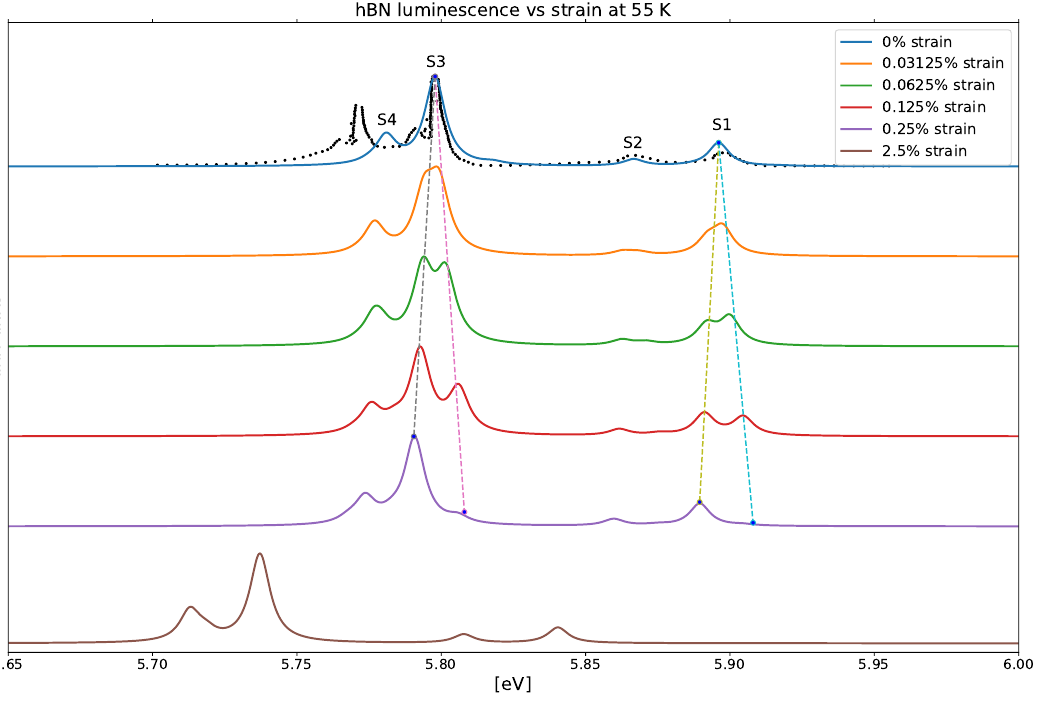
Figure 8: [ Color online ] Luminescence versus strain, for different compressions. On the top plot, experimental data is represented by the black dots from Ref. [ 36 ] . The spectra has been shifted to match the position of the iX compensate the difference between one-shot and self-consistent GW [ 37 ] . Dashed lines are just for the